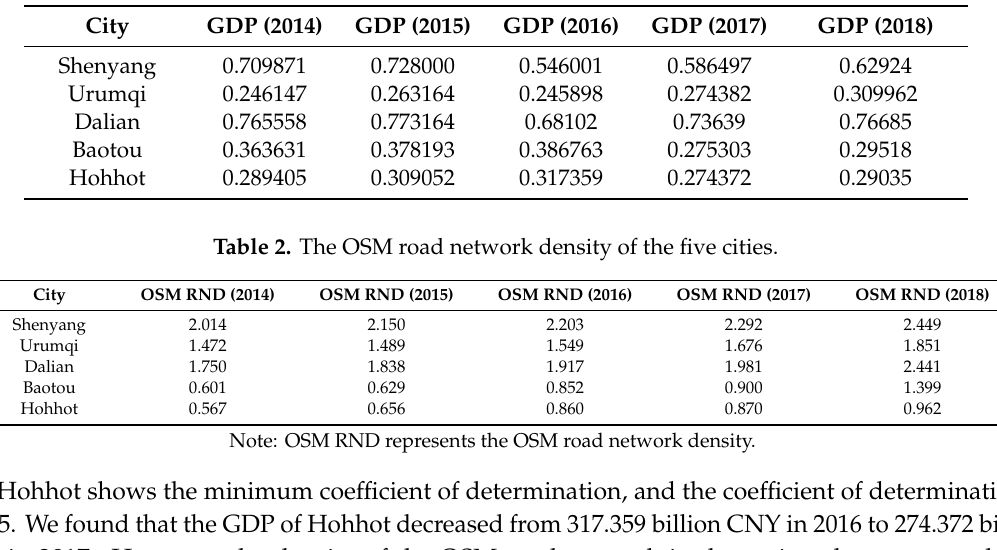
Table 1. The Chinese municipal GDP (trillion CNY) statistical results of five cities.